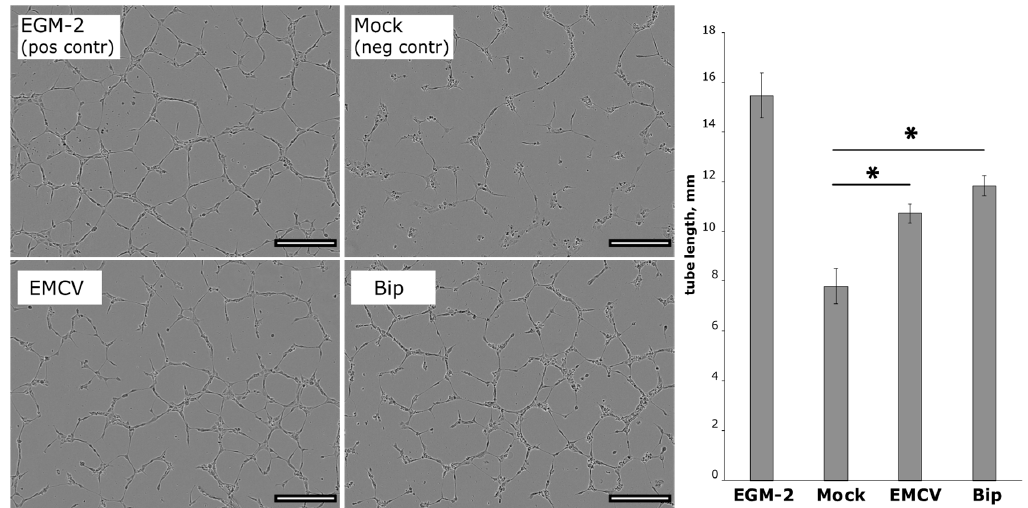
Figure 2. Results of tube formation assay after incubation of human umbilical vein endothelial cells (HUVECs) with culture medium from HEK293T transfected by IRES-based plasmid vectors. In Bip and encephalomyocarditis virus (EMCV), samples’ tube length was significantly higher vs. mock control (medium from mock-transfected HEK293T based on DMEM with 0.5% FBS) (* p = 0.0002 and p = 0.03, respectively); number of branching points was significantly increased in “Bip” and “EMCV” samples (* p = 0.0001 and p = 0.039 vs. mock control, respectively). Endothelial growth medium